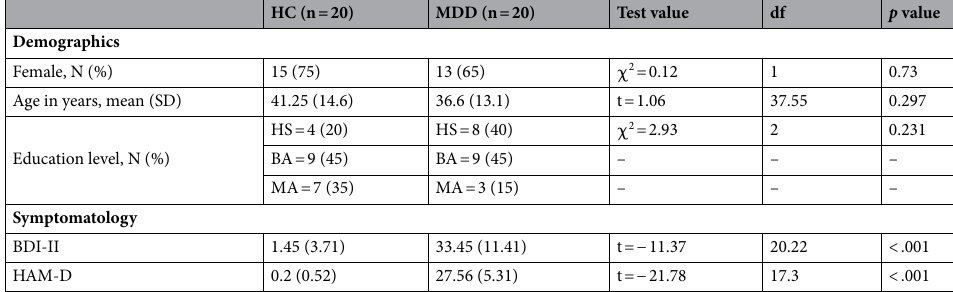
Table 1. Participant demographic and clinical characteristics. Numerical data entries are in the form: mean (SD). Statistical evaluation was conducted with chi-square tests ( χ 2 ) and student t-tests (t). HC